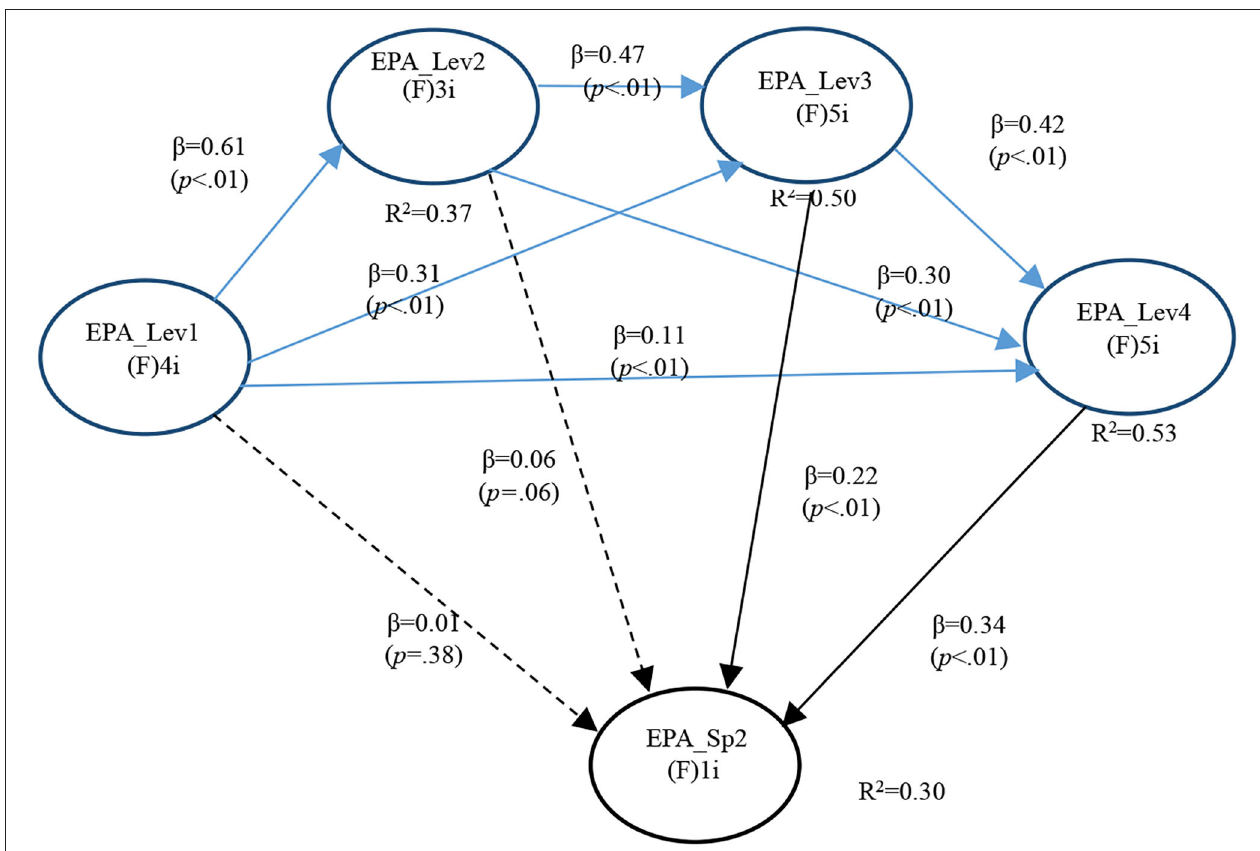
FIGURE 2 | Full model for GI EPA